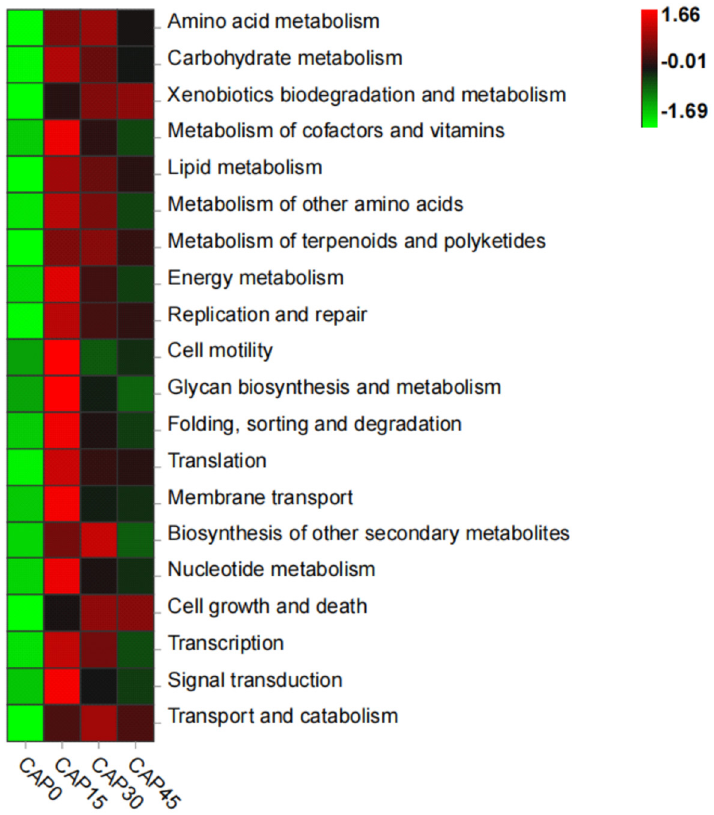
Figure 6. Predicting the functional distribution of gut microbiota using PICRUSt2 at level.